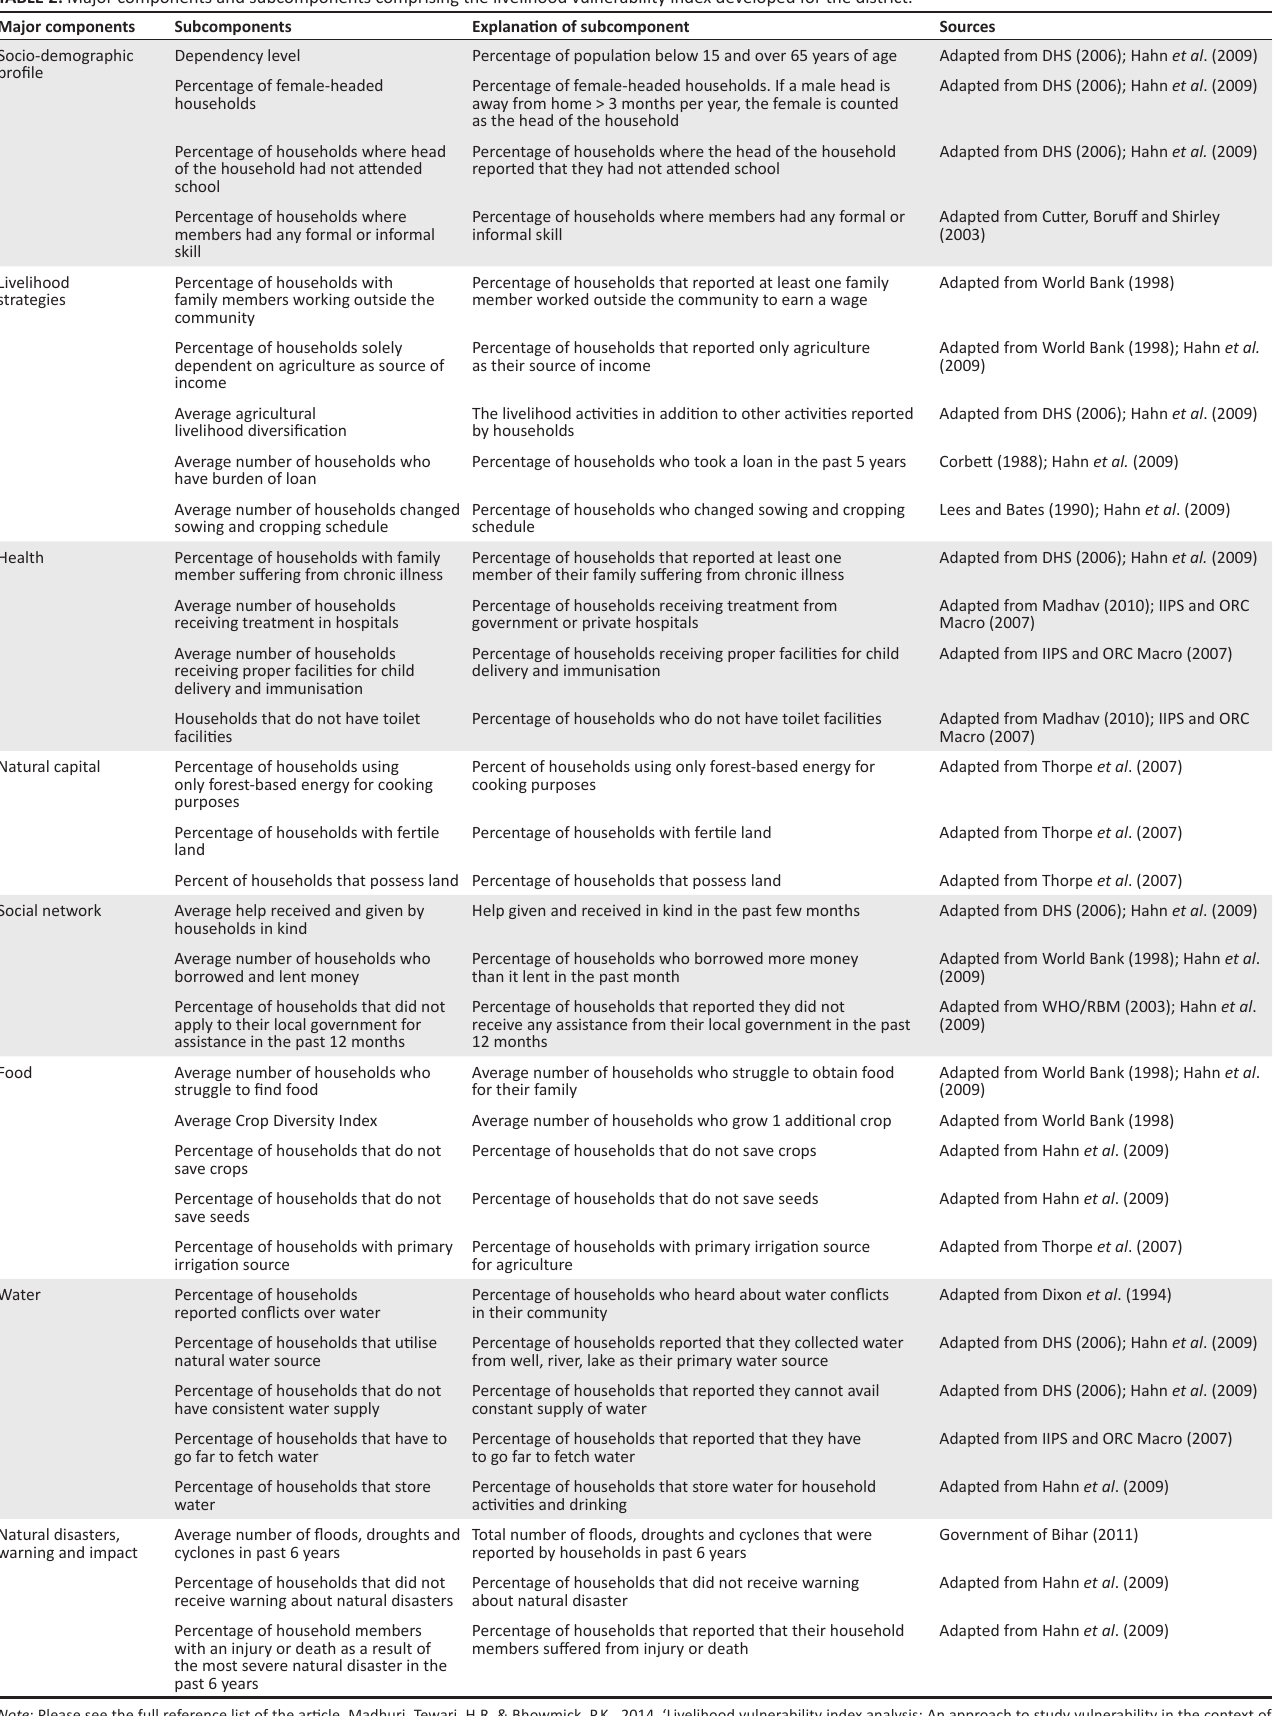
TABLE 2: Major components and subcomponents comprising the livelihood vulnerability index developed for the